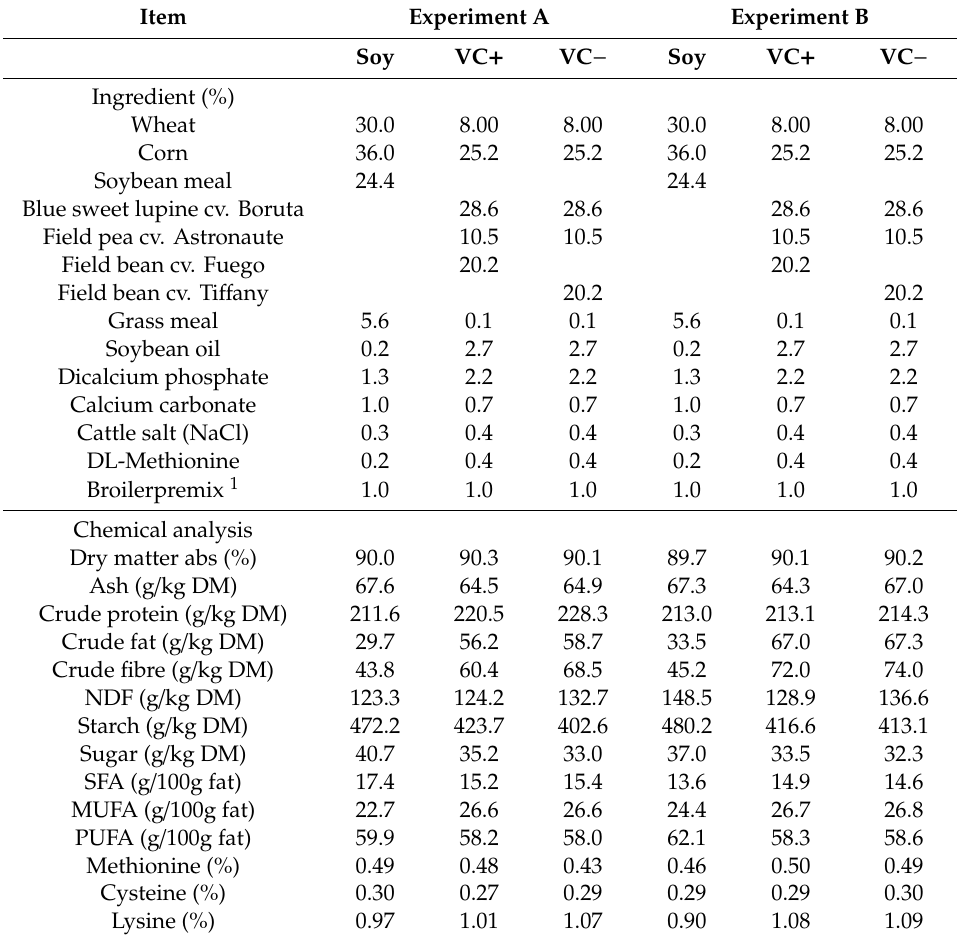
Table 1. Composition of diets and chemical